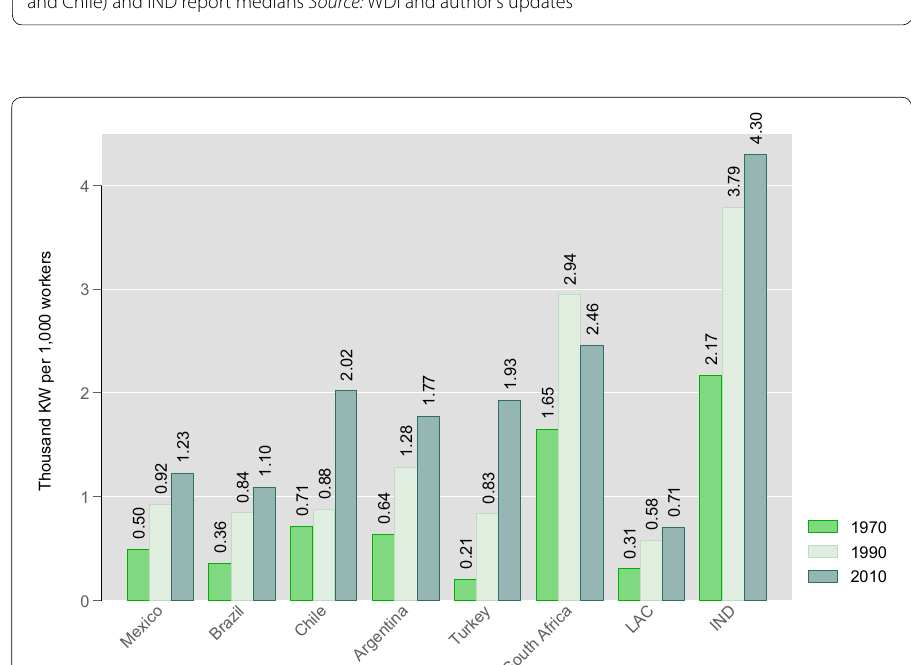
Fig. 2 Overview of energy infrastructure. Note LAC region (excludes Mexico, Brazil, Argentina and Chile) and IND report medians Source: EIA